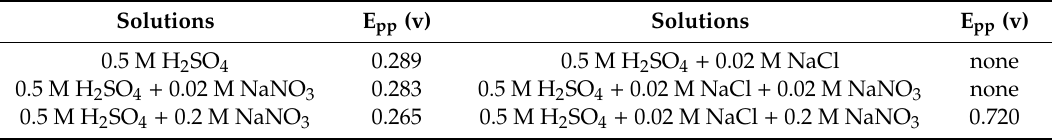
Table 1. Effects of NO 3 − ions and/or Cl − ions on the primary passive potential (E pp ) in different solutions.